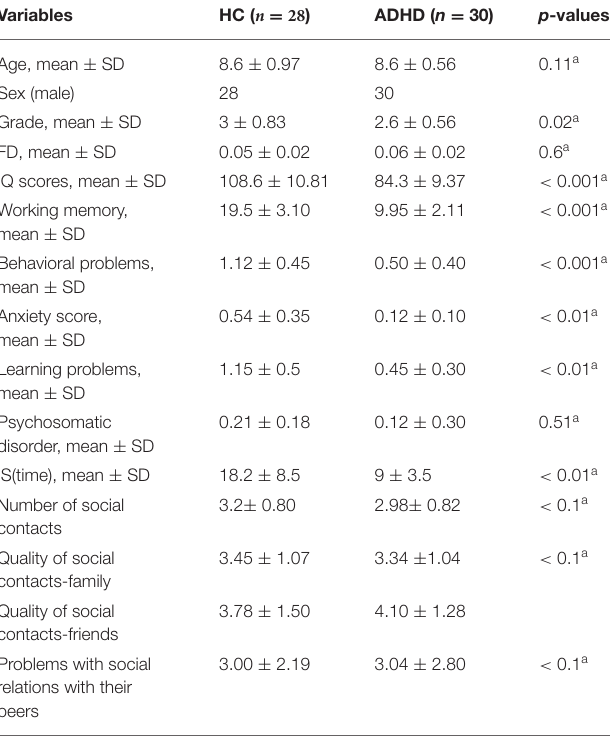
TABLE 2 | Demographic and clinical